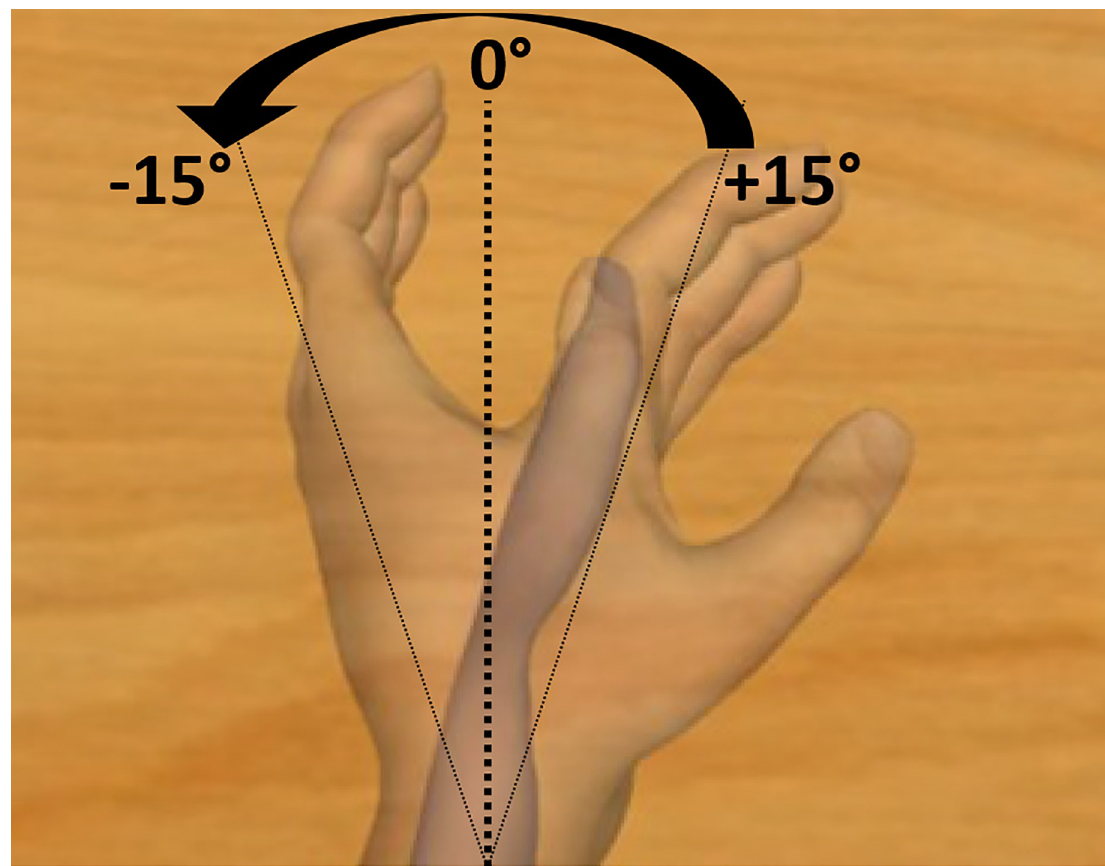
Fig 2. Description of the moving condition. Movement from wrist flexion to wrist extension, with a total displacement of 30 degrees around the rest position. The values and arrow are not visible by the participant during the experiment.